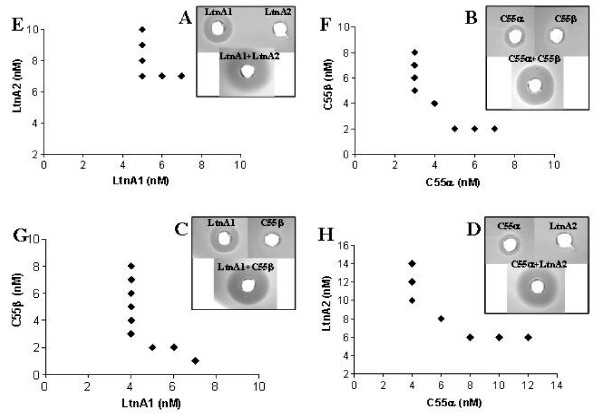
(A and B) Illustration of the requirement for synergistic activity of both structural components of the lantibiotics lacticin 3147 (LtnA1 and LtnA2) and staphylococcin C55 (C55α and C55β) for full activity of the lantibiotic. C and D illustrate cross complementation of the structural peptides of lacticin 3147 with those of staphylococcin C55. Isobologram graphs show nanomolar concentrations of purified peptides of lacticin 3147 with those of staphylococcin C55. Each point on the graph represents 50% growth inhibition of the indicator L. lactis HP. Isobolograms of (E) represent purified lacticin peptides LtnA1 and LtnA2 titrated against each other, (F) represent purified staphylococcin C55 peptides C55α and C55β titrated against each other, (G) represent purified lacticin LtnA1 peptide titrated against staphylococcin C55β and (H) represent purified staphylococcin C55α titrated against lacticin LtnA2 peptide.